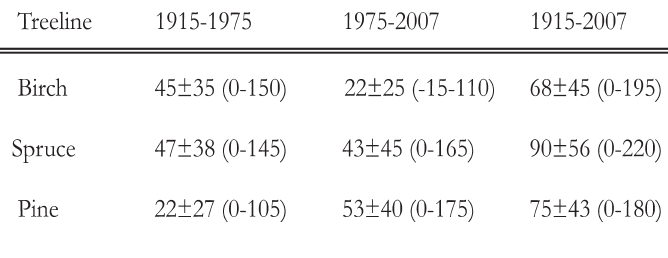
Table 1. Species-specific magnitudes of altitudinal treeline shifts during different periods of time. Source: Kullman & Öberg